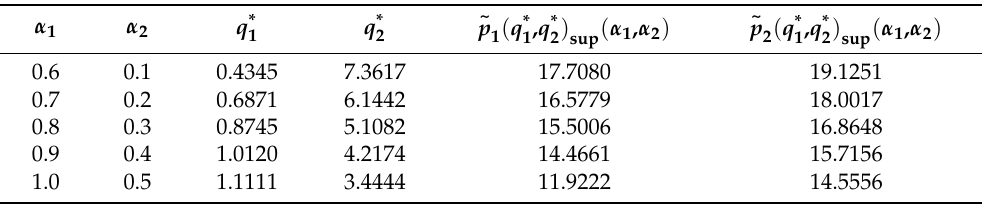
Table 10. ( α 1 , α 2 )-optimistic equilibrium quantity for Scenario III when the risk aversion levels for CDT and AG increase.